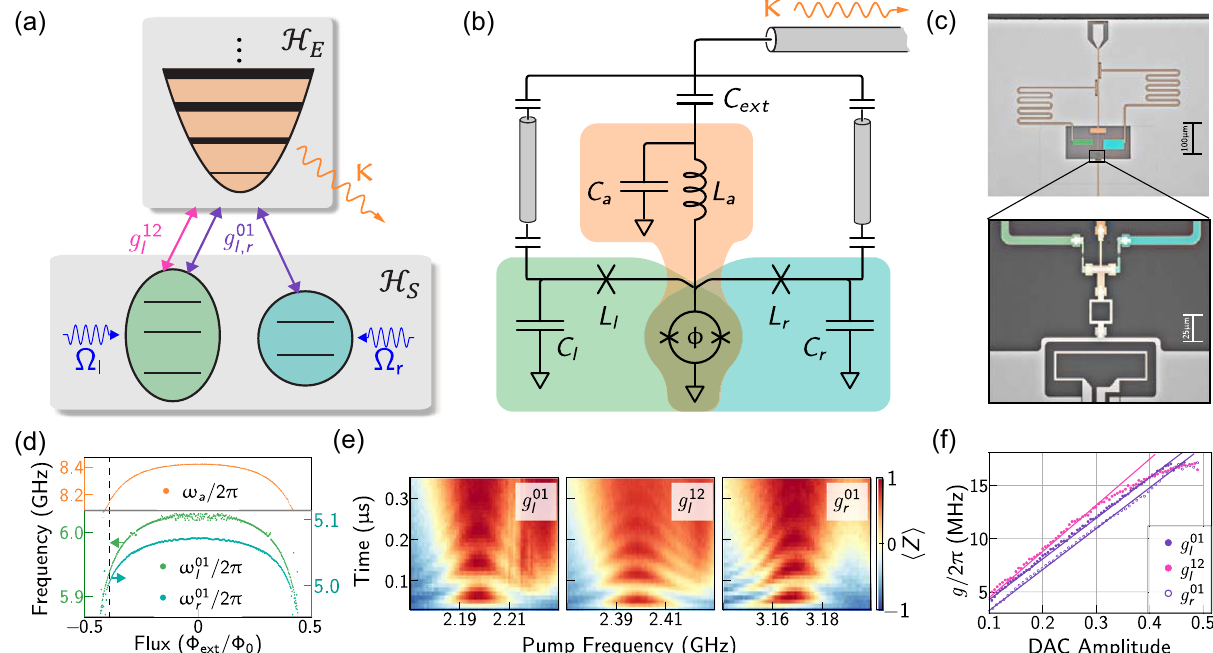
Fig. 1 Device design and characterization. a Schematic diagram showing a lossy resonator with linewidth κ coupled to a qutrit-qubit system via three parametric drives. Rabi drives resonant with the 0 – 1 transition are also applied to both the qutrit and the qubit. b Circuit realization of the scheme in a showing two superconducting transmons (green and turquoise) and central resonator (orange), as well as the dedicated readout resonators (gray). The transmons and central resonator share a SQUID that implements parametric couplings ( g n ; n þ 1 ). c Optical micrographs of the device layout (left) and a k magni fi ed view of the junctions and the SQUID coupler (right). The external bias line used to pump the SQUID can be seen at the bottom of the device. The resonator consists of an array of 10 Josephson junctions, each having a critical current I ac ≈ 540 nA, in series with a fi xed capacitor. d Measured 0 – 1 transition frequency for each transmon and resonator center frequency as a function of fl ux through the SQUID loop. The operating fl ux bias is indicated with a dashed-black line. e Time-domain parametric swaps measured as a function of pump frequency for each of the three parametric drives in Eq. (1). From left to right, the transmons are initialized in 10 j i , 20 j i , and 01 j i respectively. f Parametric coupling rates measured as a function of pump amplitude. Solid lines are linear fi ts to the data; the nonlinear response of g 12 at higher drive amplitude is due to enhanced mixer saturation at the corresponding IF l frequency of 150 MHz, as compared to the other drives, which use 50